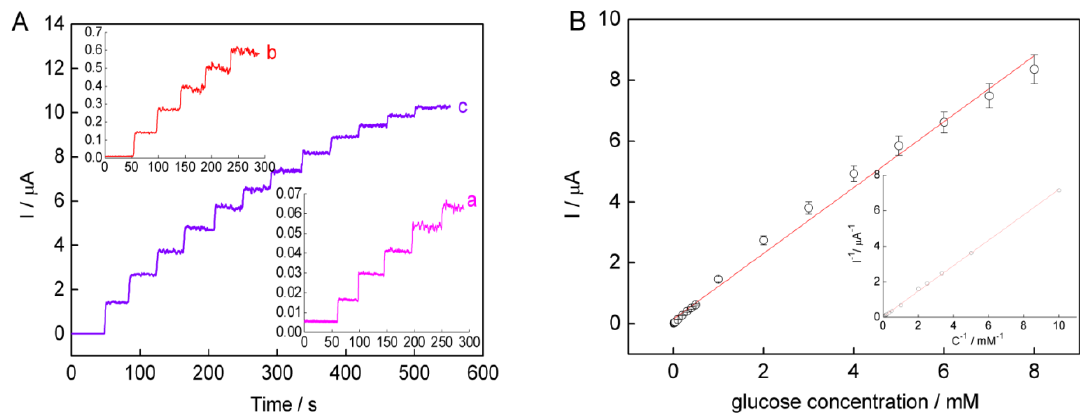
Figure 6. ( A ) Current-time curves obtained at the sol-SWCNTs-(AuNRs-GOD) 4 /Au electrode for successive additions of 0.01 mM (curve a), 0.1 mM (curve b), and 1 mM (curve c) glucose in PBS at 0.35 V vs . saturated calomel electrode; ( B ) The calibration curve of the enzyme electrode as a function of glucose concentrations. Inset shows K . Error bar = standard deviation ( n = Lineweaver-Burk plot for the determination of app m